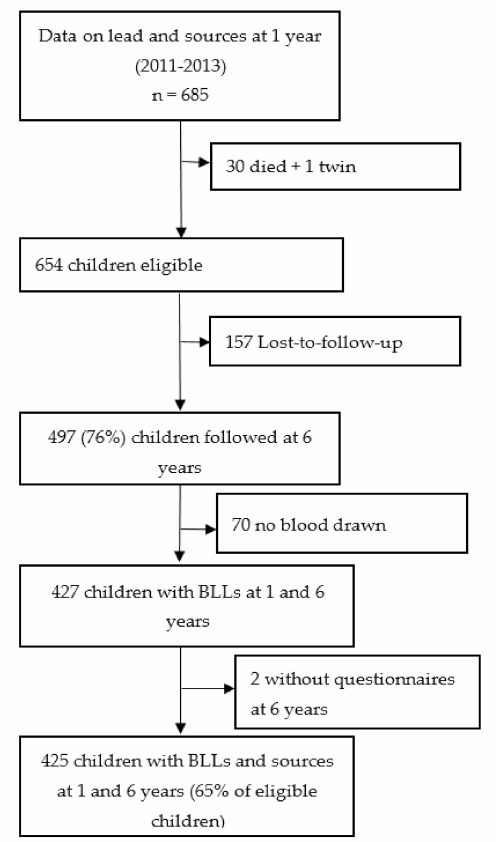
Figure 1. Summary of participant selection. BLLs = blood lead